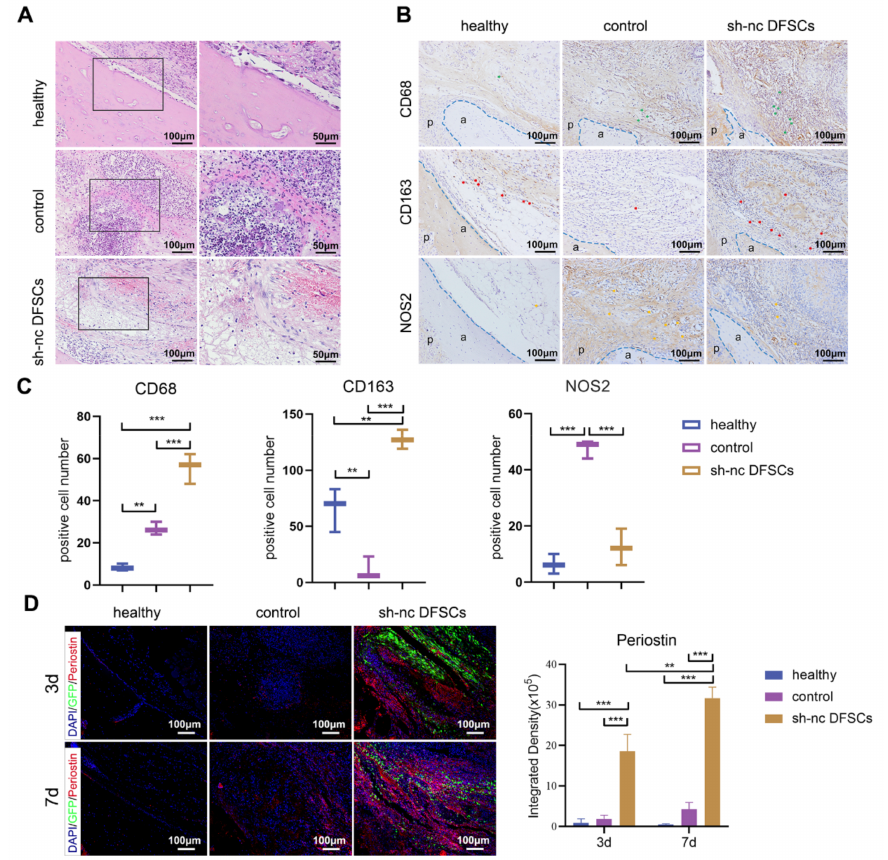
Figure 2. DFSCs improved the immune microenvironment and highly expressed periostin. ( A ) HE staining of the defect areas of the control and sh-nc DFSCs groups at 3 days after transplantation.